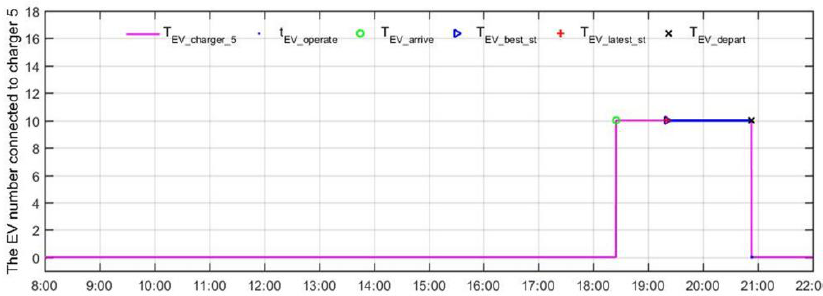
Figure 32. Operating time of EVs connected to charger 5 under SPVA.